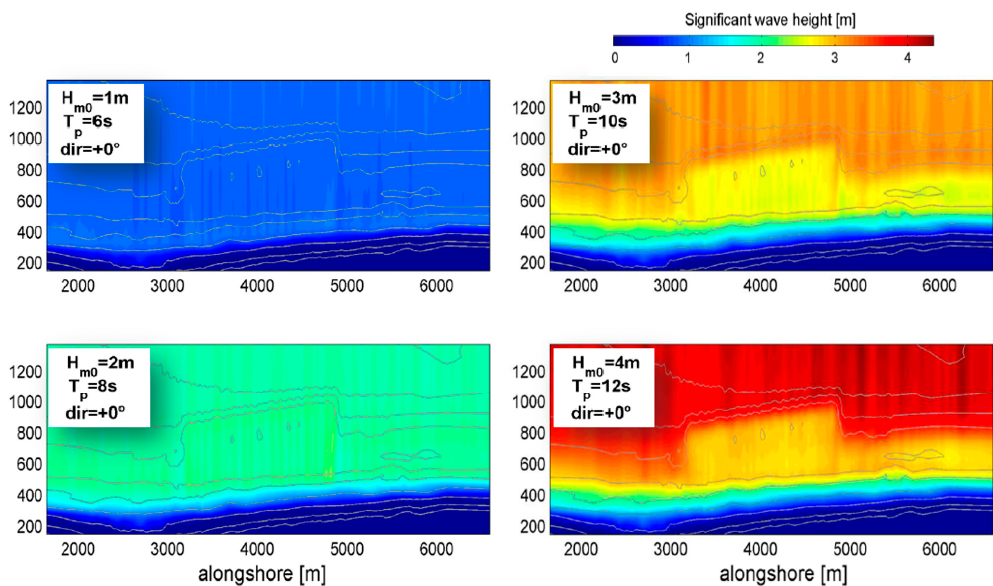
Figure 11. Modelled wave transformation for four shore-normal wave height classes at the Ter Heijde’97 shoreface nourishment using the XBeach model (using January 1998 bathymetry survey).